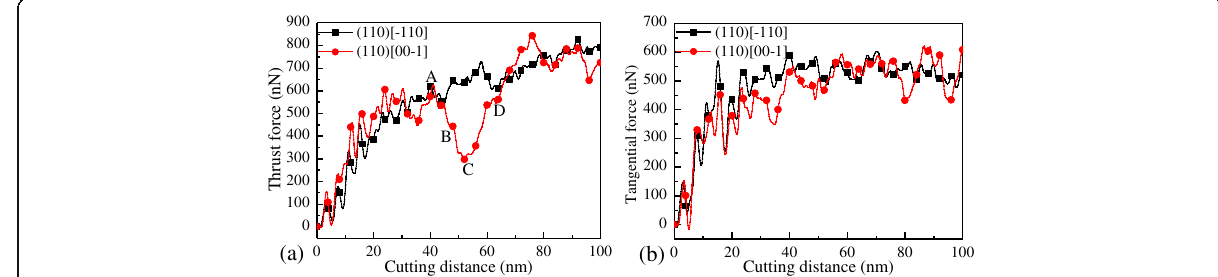
Fig. 7 a Thrust forces and b tangential forces during nanometric cutting on the (110) crystal plane